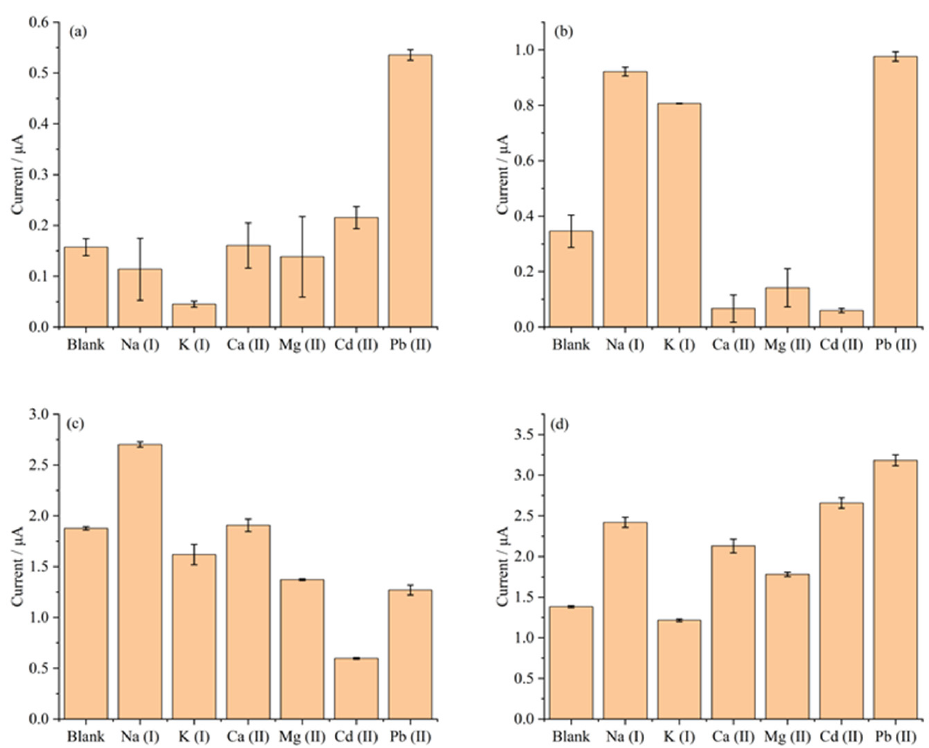
Figure 4. Selectivity of aptamer-IIP-Pb(II) ( a ), aptamer-Pb(II) ( b ), IIP-Pb(II) ( c ), and CS–GO ( d ) sensors for detecting 1 μ M Pb (II).